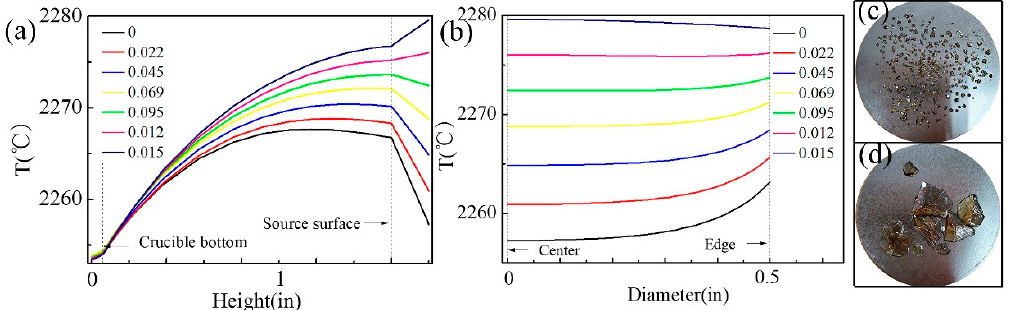
Figure 6. ( a ) Temperature profile along axis of symmetry inside the crucible under different power ratio; ( b ) The radial temperature profile on the substrate under different power ratio; ( c ) The experimental result without nucleation control; ( d ) The experimental result with nucleation control.